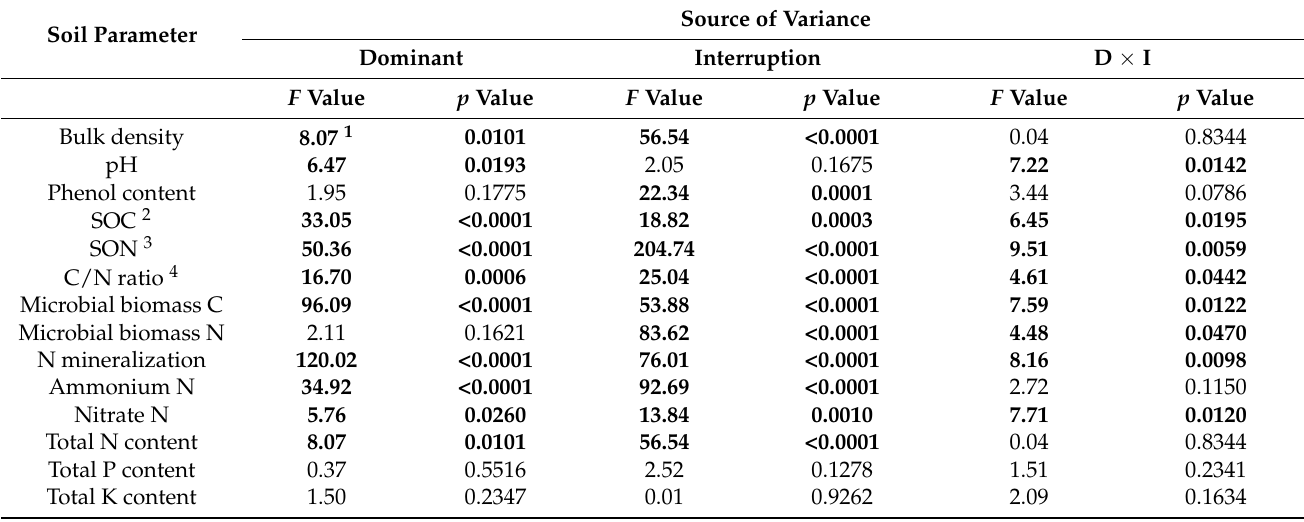
Table 1. Analysis of variance (ANOVA) effect of dominant (D) species ( Ledum palustre vs. Vaccinium uliginosum ) of understory communities, interruption (I) treatment of removing dominant species, and their interaction (D × I) on soil properties in forests of northeast China.